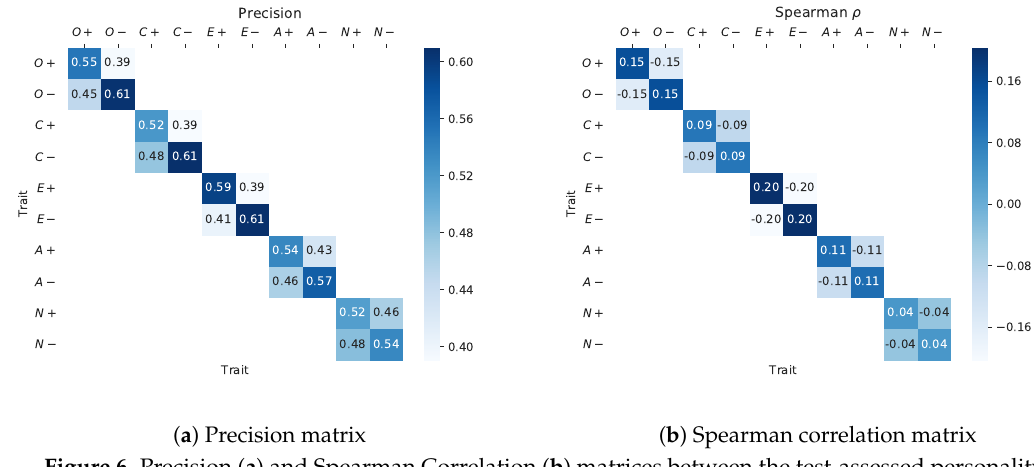
Figure 6. Precision ( a ) and Spearman Correlation ( b ) matrices between the test-assessed personality traits and the image choices. Users with a given level of a trait tended to like the same model-selected